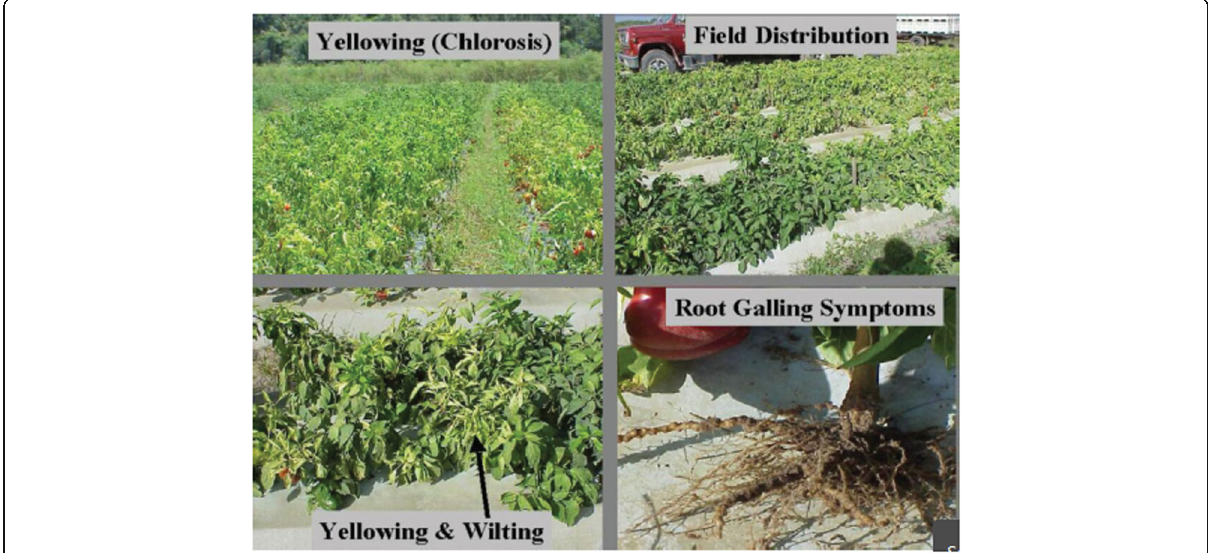
Fig. 1 Wilting, yellowing, and stunting of pepper due to the root-knot nematode ( Meloidogyne spp.). Note the formation of galls on roots (Noling